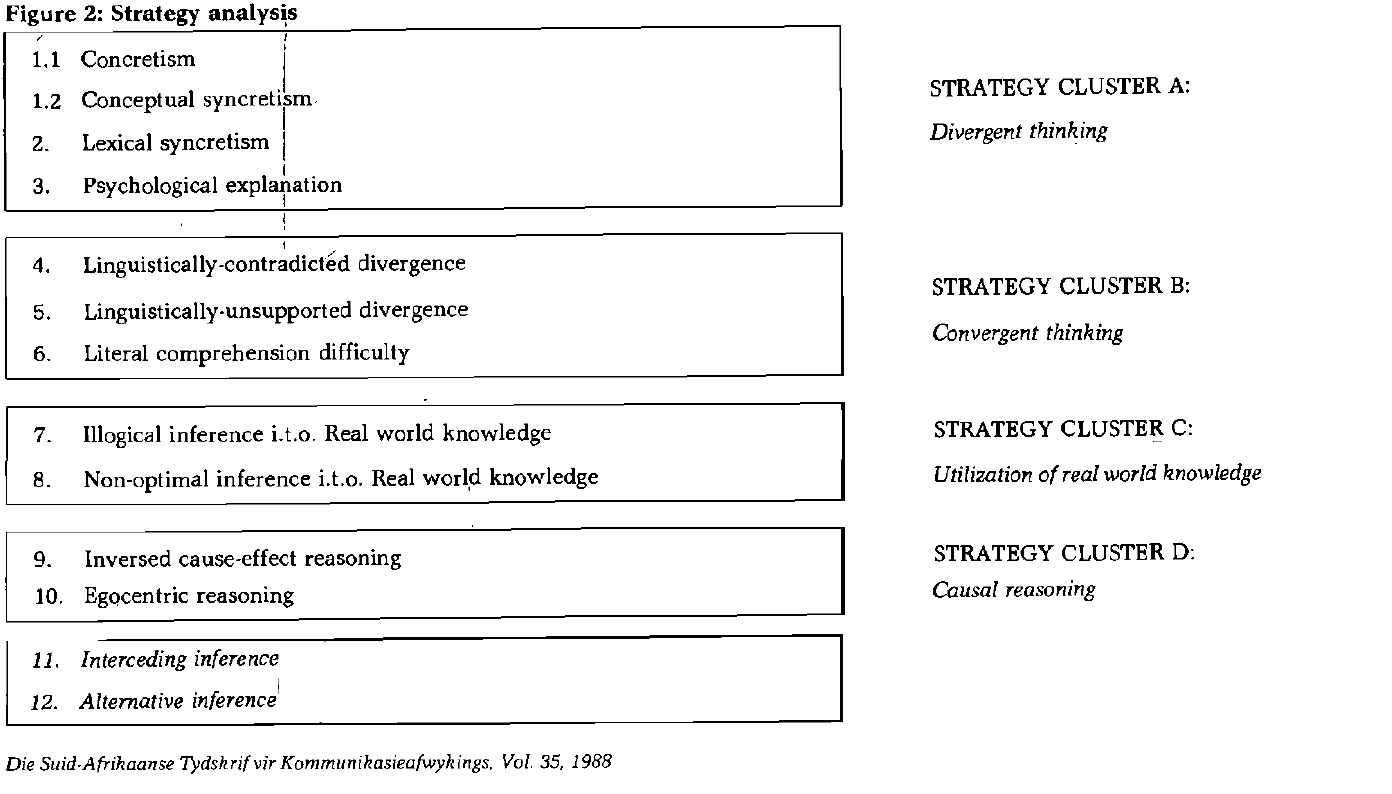
Figure 2: Strategy